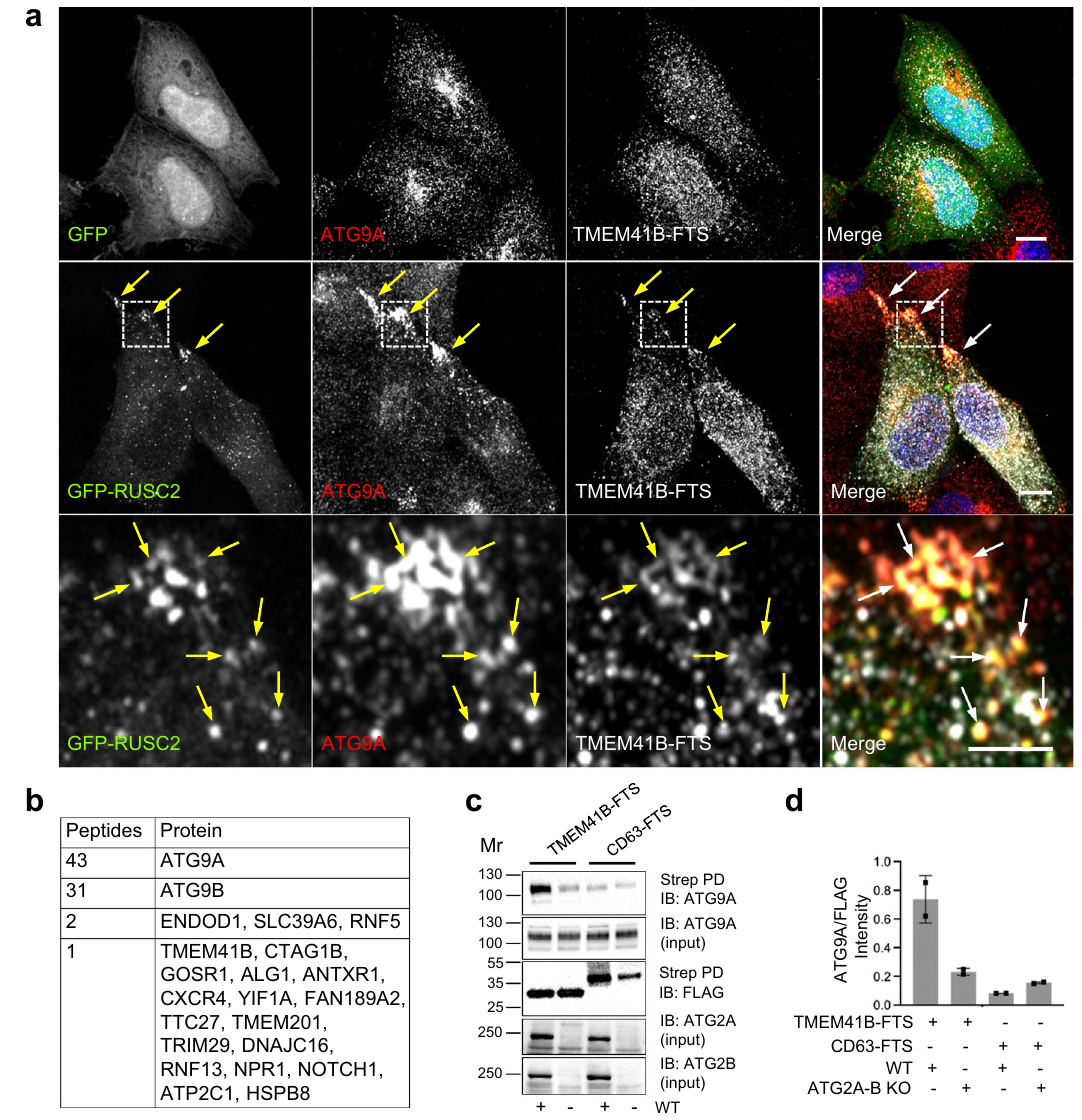
Fig. 7 Association of ATG9A and TMEM41B structures. a Redistribution of ATG9A and TMEM41B-FTS to cell vertices by overexpression of GFP-RUSC2. Confocal fl uorescence microscopy of HeLa cells transiently transfected with plasmids encoding GFP (control) or GFP-RUSC2 (green) and TMEM41B-FTS, fi xed, permeabilized and stained with antibodies to endogenous ATG9A (red) and FLAG epitope (to label TMEM41B-FTS) and with DAPI (blue). Single- channel images are shown in grayscale. Scale bars: 10 μ m. Enlarged views of the boxed areas are shown in the bottom row. Scale bar: 1 μ m. Co-localization at cell vertices is indicated by arrows. Results are representative from three independent experiments. b Summary of TAP-MS analysis of proteins that co- purify with ATG9A-FTS. Raw data are shown in Supplementary data 1. c Validation of ATG9A-TMEM41B interaction by Strep-Tactin pulldown (Strep PD) and IB. WT and ATG2A-B-KO HeLa cells were transiently transfected with plasmids encoding TMEM41B-FTS or CD63-FTS (non-speci fi c control). Cell extracts were incubated with Strep-Tactin beads, and bound and input proteins analyzed by SDS-PAGE and immunoblotting with antibodies to ATG9A, ATG2A, ATG2B and the FLAG epitope. The positions of molecular mass (Mr) markers (in kDa) are indicated on the left. d Quanti fi cation of the ratio of ATG9A in the PD to FLAG in the input in two experiments such as that shown in c . Bars represent the means ± SD from two independent